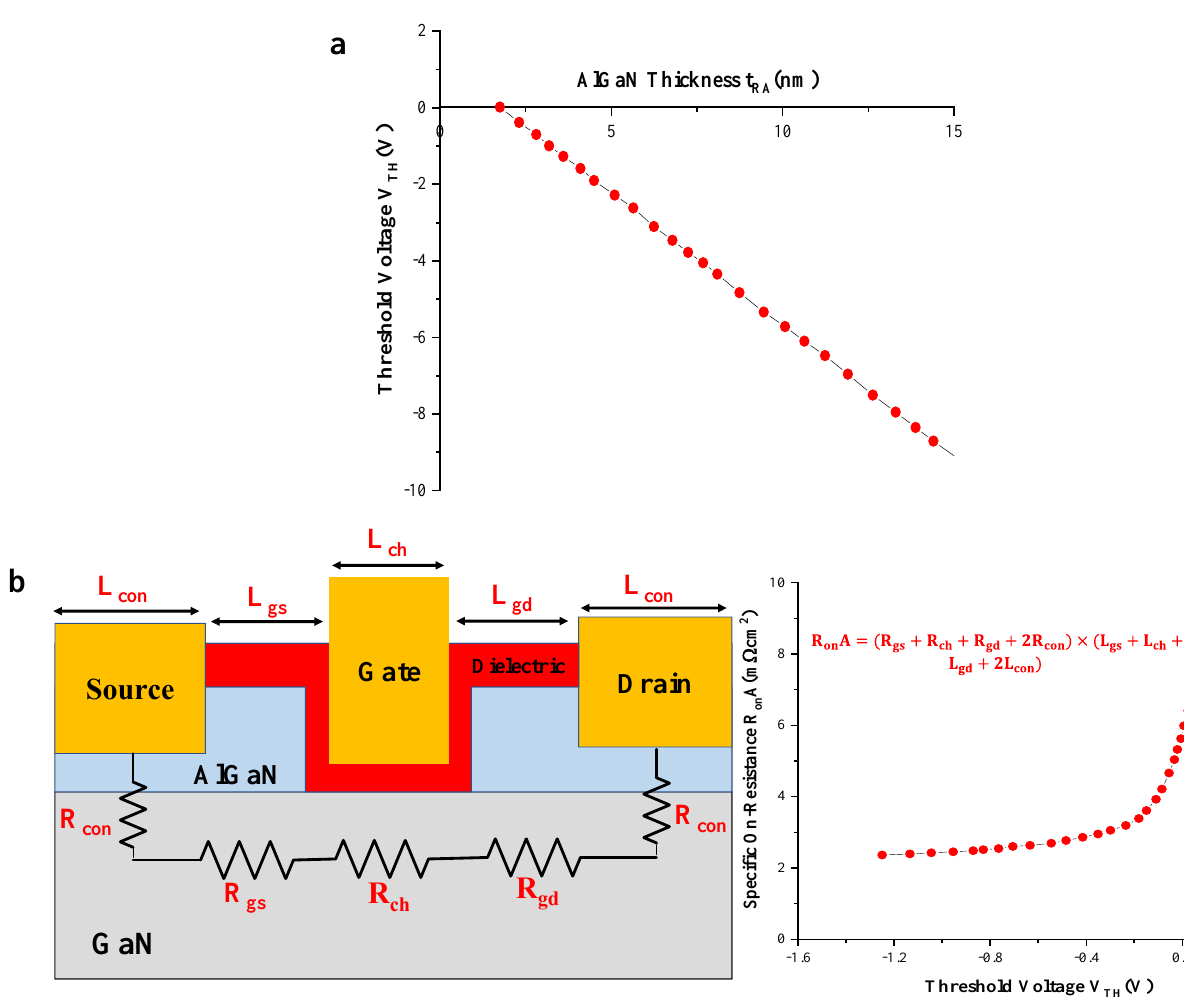
Figure 26. ( a ) The AlGaN layer thickness and gate threshold voltage relation. ( b ) In the recessed- gate GaN HEMT, the calculation of specific on-resistance and the relation between the threshold voltage and the specific on-resistance. Reprinted under the open access policy from Bentham Open [132].